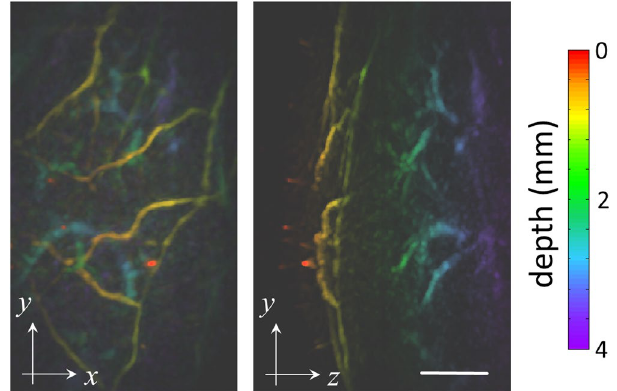
Figure 5. Deep-tissue imaging of mouse microvasculature in vivo . Maximum intensity projections of the 3D optoacoustic images are displayed color-coded for depth. Scalebar – 1